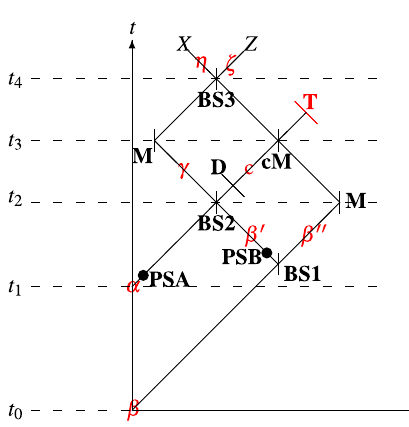
Figure 3. Space-time diagram of a communication scheme proposed for relativistic QKD. α signal (weak) state, β reference (strong) state, PSA phase shift possessed by Alice, PSB phase shift possessed by Bob, BS beam splitter, D detector, M mirror, cM controlled mirror, T